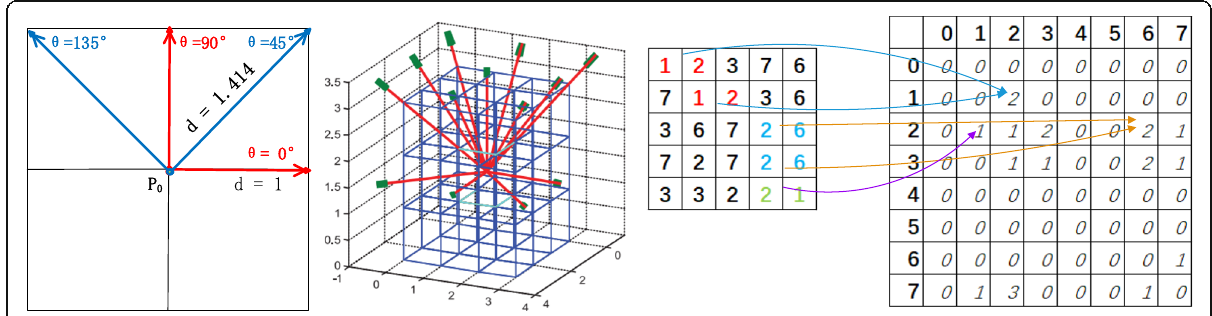
Fig. 4 Illustration of grey level co-occurrence matrices of 2 dimensional /3 dimensional images. Left pannel : 2 dimensional grey level co-occurrence matrices (GLCM) calculation; Middle pannel : 3 dimensional GLCM calculation; Right pannel : A GLCM example when angle( θ ) = 0°, displacement(d) =